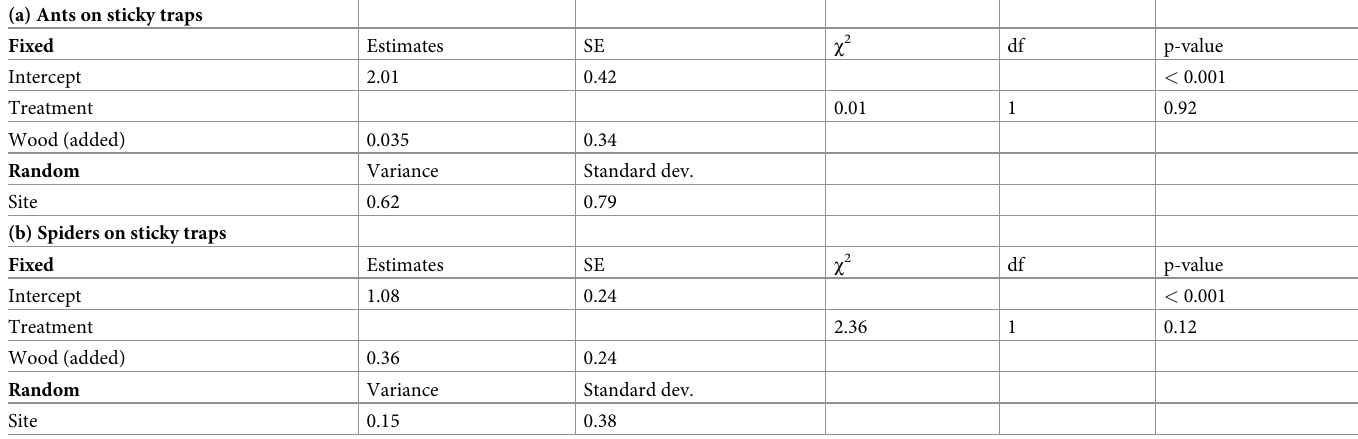
Table 3. Anova (type II test) and summary table for generalised linear mixed models testing the difference in number of a) ants and b) spiders caught on the sticky traps against the dead wood treatment (added or removed). Dead wood treatment was used as a fixed factor, and site as a random factor.